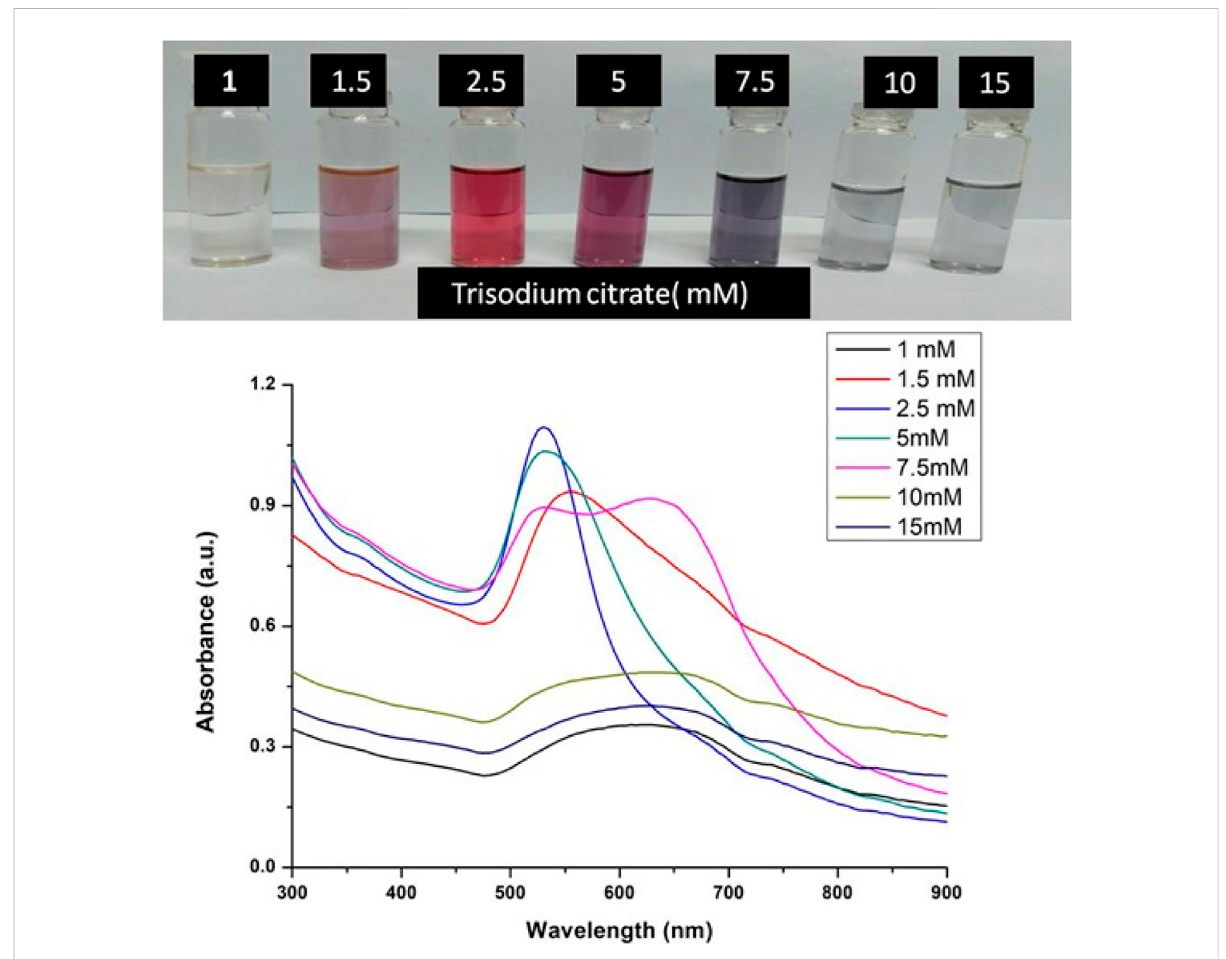
FIGURE 2 UV-Vis Spectra of Gold nanoparticles solutions synthesised by varying concentrations of trisodium citrate dihydrate. The experiments were done in triplicate and results within each pair differed by < 3.